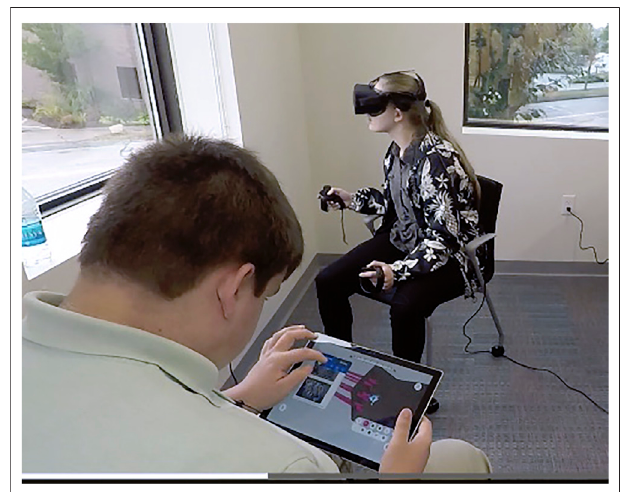
FIGURE 3 | Two players using the collaborative version of Cellverse